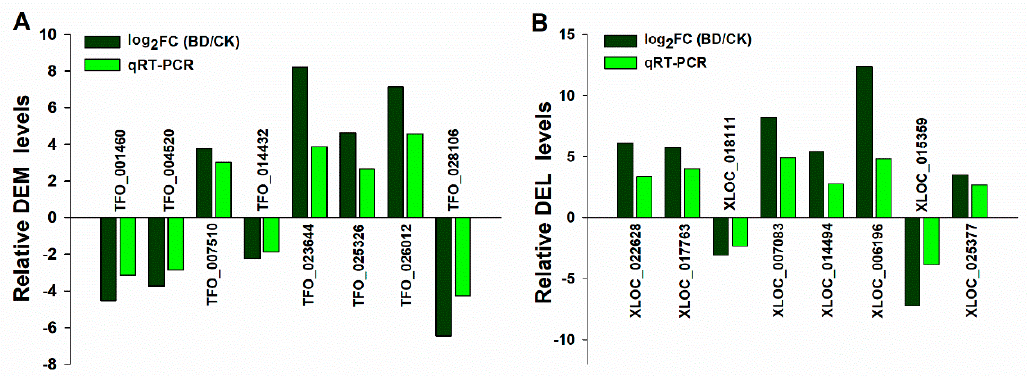
Figure 4. Quantitative real-time polymerase chain reaction (qRT-PCR) validation of expression levels of differentially expressed lncRNA (DELs) and differentially expressed mRNA (DEMs) in the leaf of trifoliate orange under boron deficient stress. ( A ) qRT-PCR validation of expression levels of candidate DEMs in the leaf of trifoliate orange under boron deficient stress. ( B ) qRT-PCR validation of expression levels of candidate DELs in the leaf of trifoliate orange under boron deficient stress. BD: Boron deficiency; CK: Control. FC: Fold change.